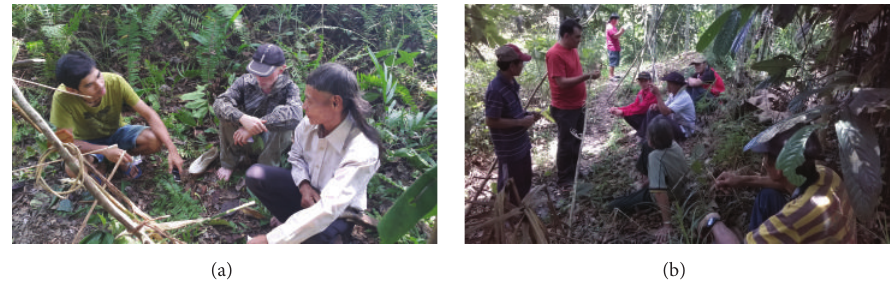
Figure 9: (a) Oroo’ demonstration session in Long Kerong. (b) Oroo’ demonstration session in Long Lamai.